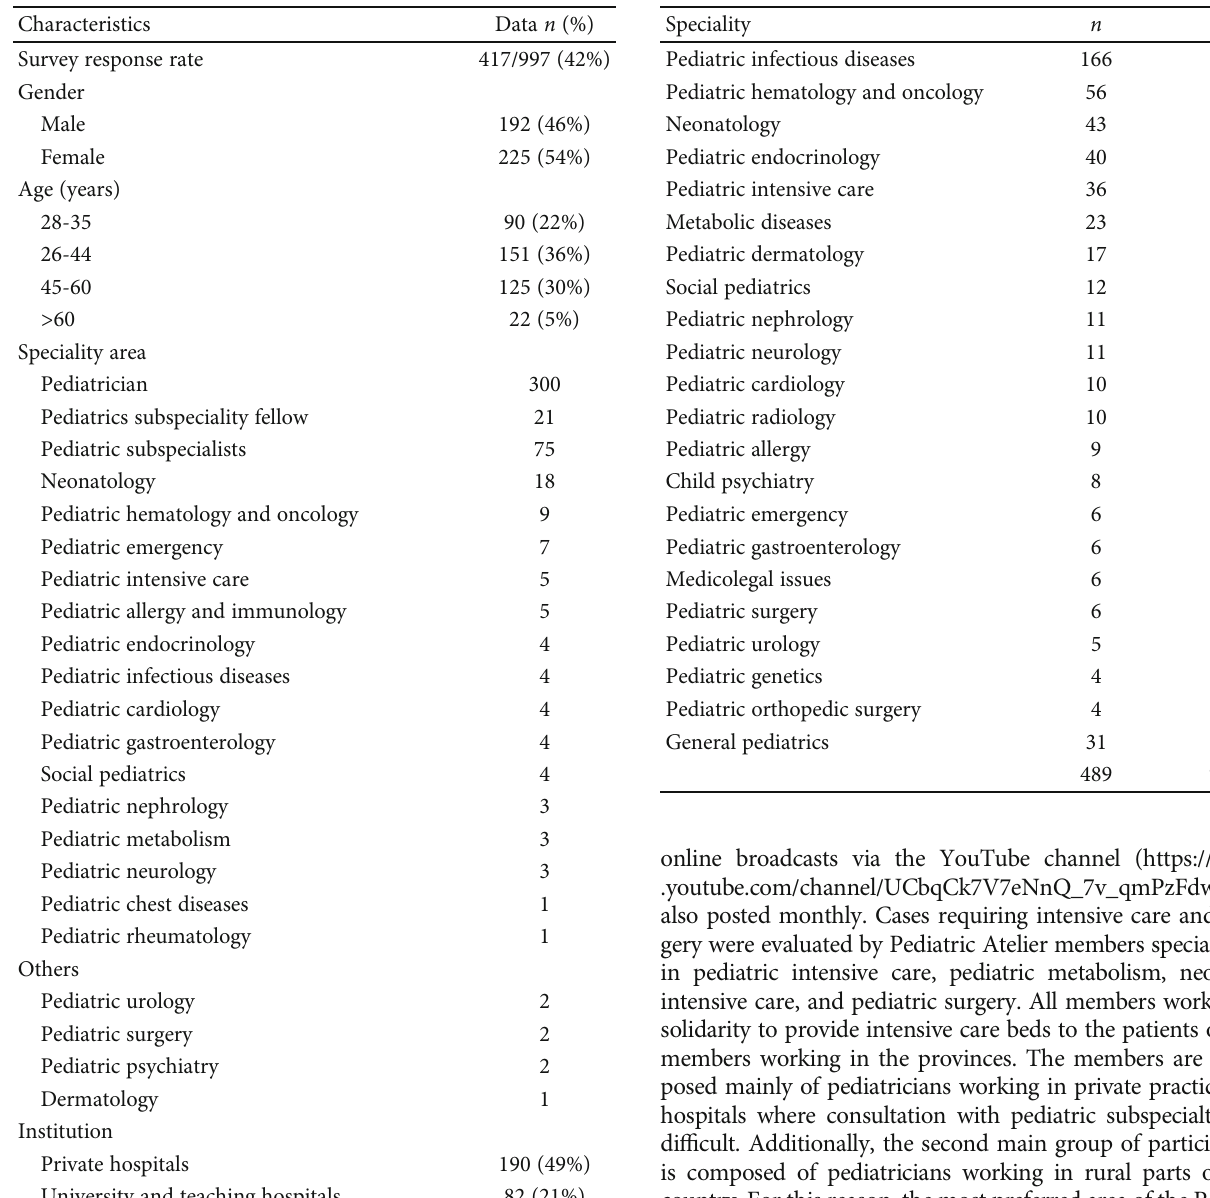
Table 1: Respondent demographics and survey results. Table 2: Consultations with regard to speciality